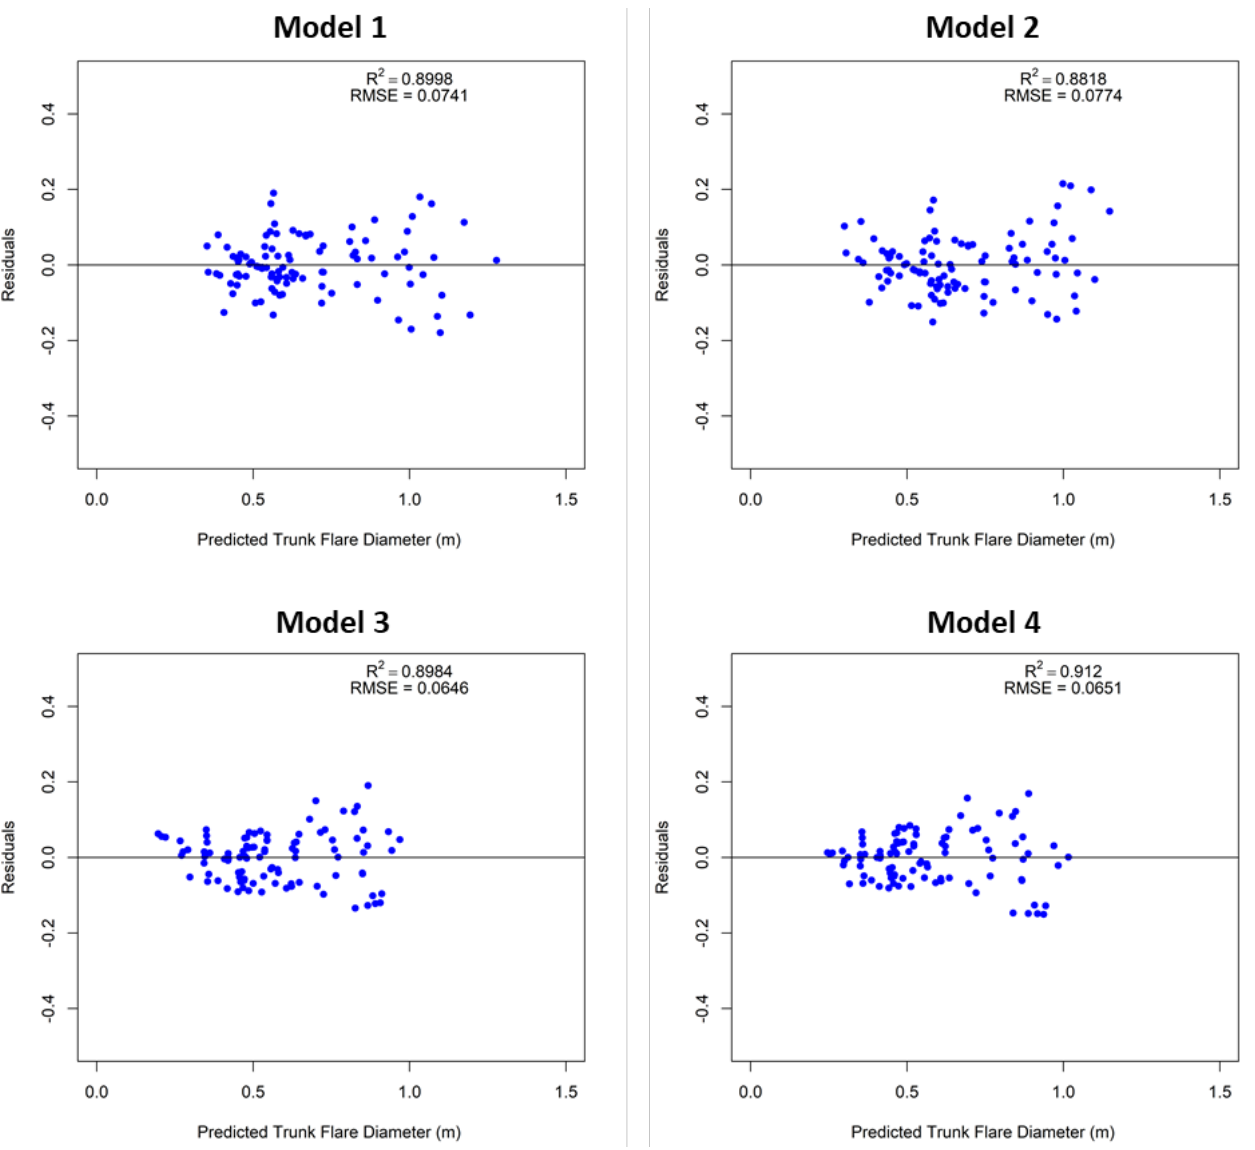
Figure 8. Residual distribution according to the predicted trunk flare diameter from the iPad Pro data (Models 1 and 2) and from the TLS FARO data (Models 3 and 4).